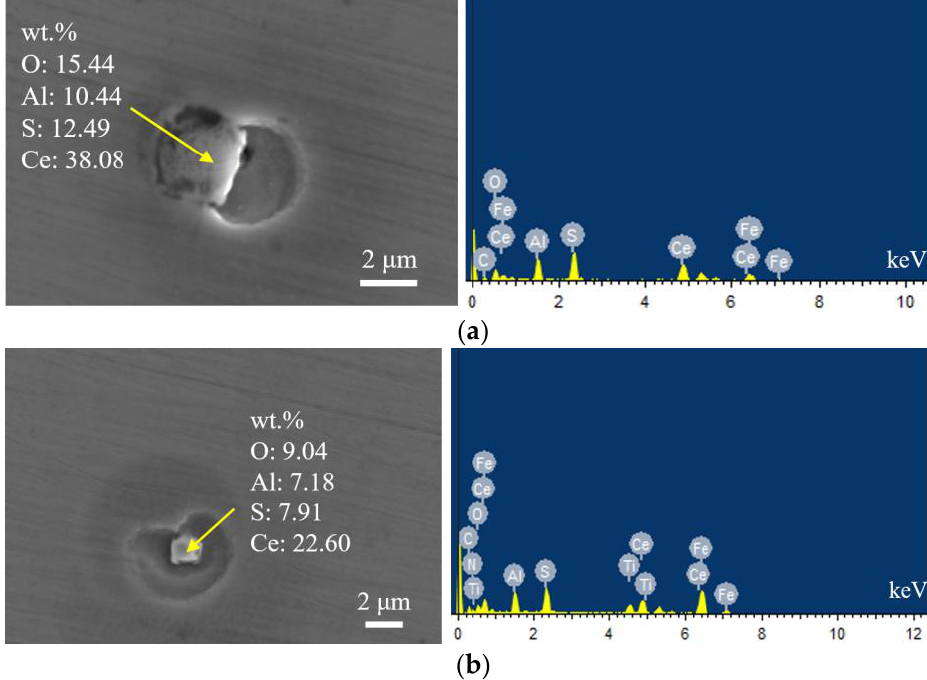
Figure 2. Typical morphology and energy spectrum of inclusions in the steel with 10 ppm Ce content.